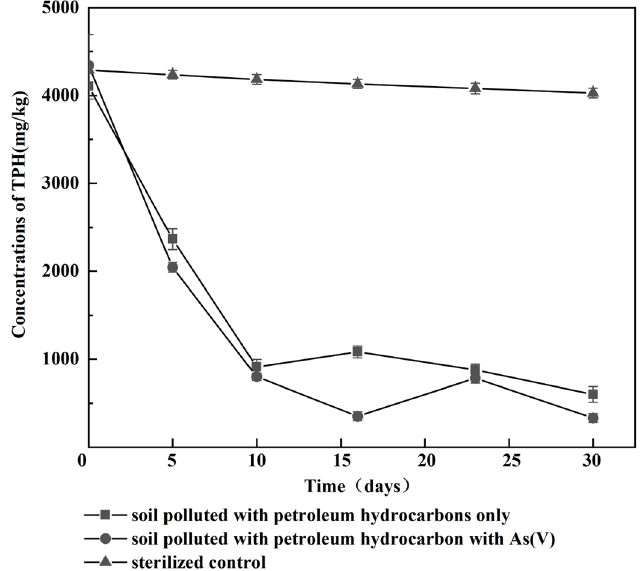
Figure 5. Effect of heavy metals in removal of hydrocarbon-polluted soils by JYZ-03 strain. Closed squares, soil polluted with petroleum hydrocarbons; closed circles, soil polluted with petroleum hydrocarbons plus As(V); closed triangles, sterilized soil polluted without inoculation.